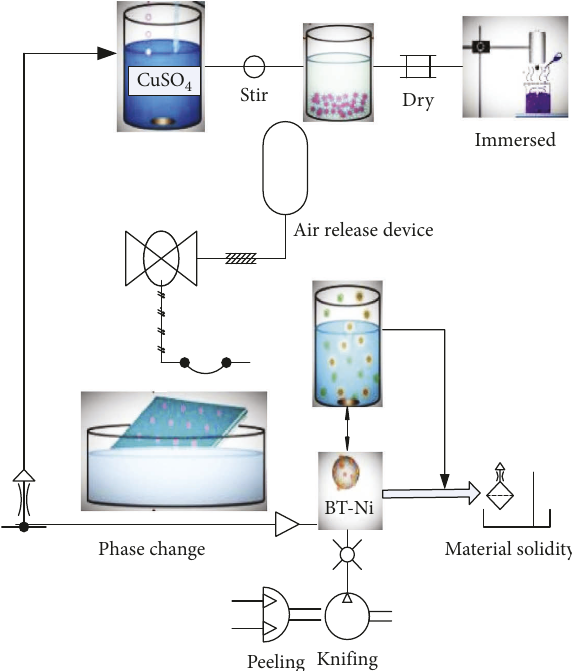
Figure 5: Performance analysis.